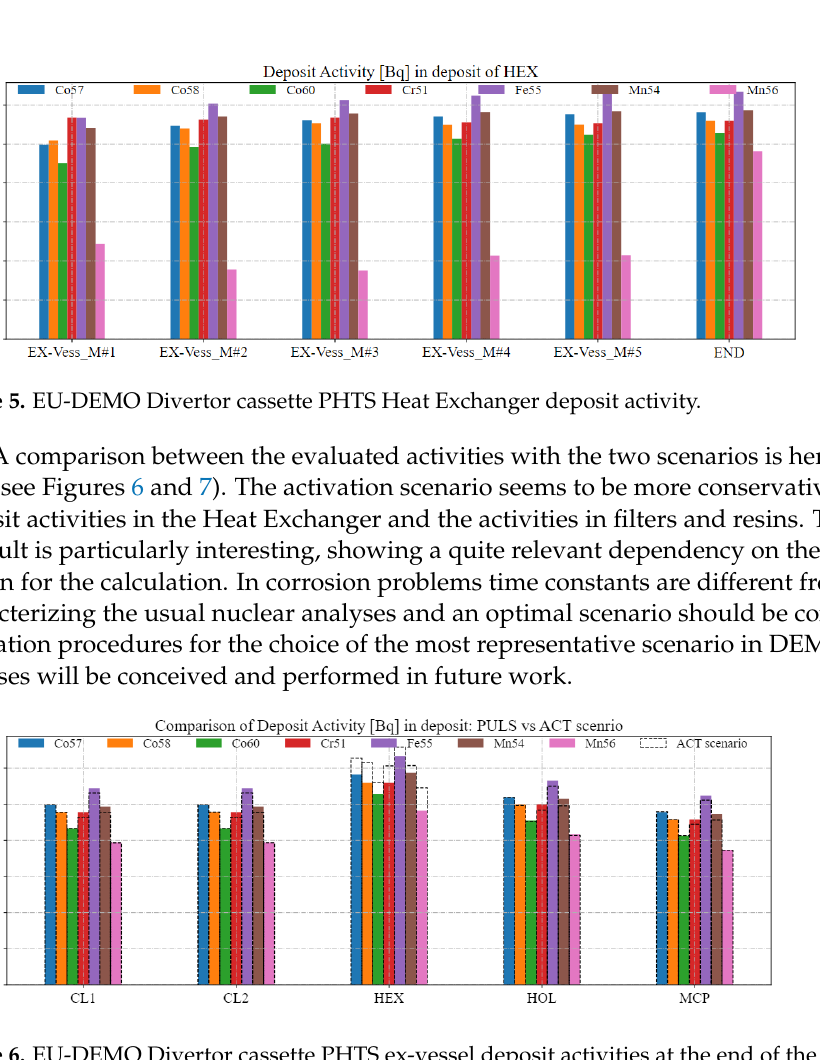
Figure 6. EU-DEMO Divertor cassette PHTS ex-vessel deposit activities at the end of the operation scenario. Comparison between the pulsed and the activation scenarios.